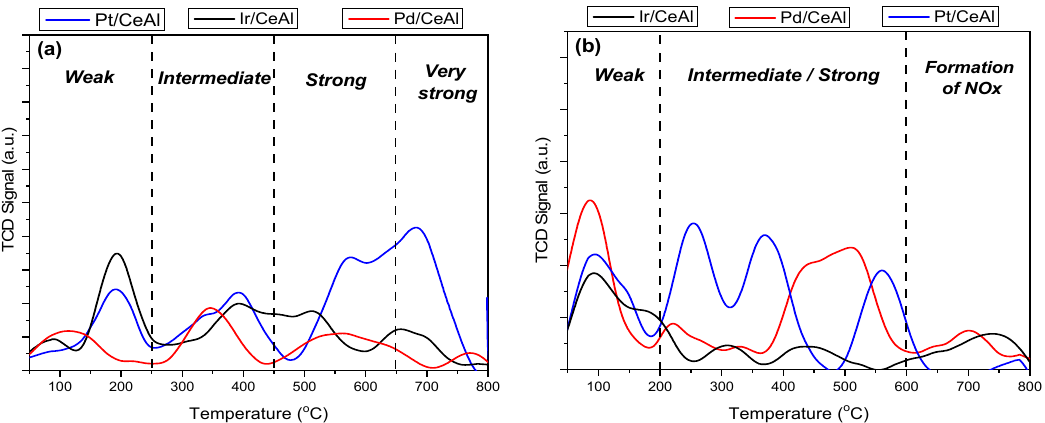
Figure 4. ( a ) CO 2 –TPD, and ( b ) NH 3 –TPD profiles of the Ir/CeAl, Pd/CeAl and Pt/CeAl calcined catalysts.